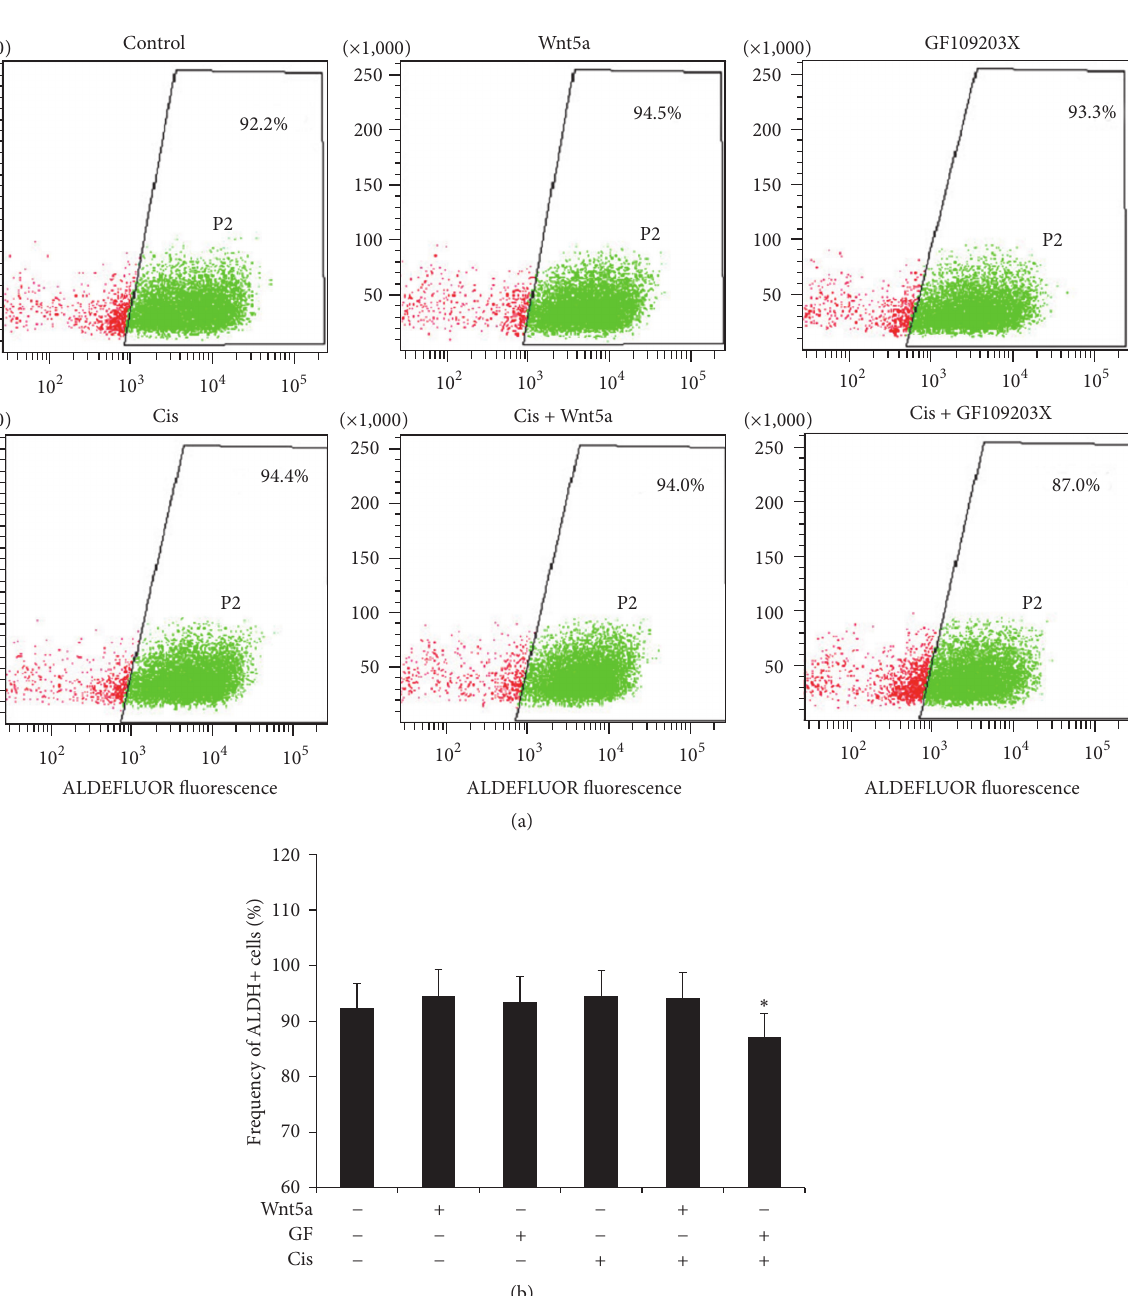
Figure 5: An inhibition of PKC signaling reduces the fraction of ALDH-positive in cisplatin-resistant lung cancer cells. A549/DDP cells were cultured in medium containing Wnt5a, PKC inhibitor GF109203X, and/or cisplatin for 24 hours; the cells were then harvested for ALDH staining and flow cytometric analysis. (a) Representative cytometric plots showed the positive fractions of ALDH-positive cells treated with indicated conditions. (b) A quantitative analysis of flow cytometry data showed Wnt5a slightly increased ALDH-positive cell fraction in A549/DDP cells in the absence of cisplatin, and an inhibition of PKC signaling by GF109203 significantly reduced the frequency of ALDH- cells in the presence of cisplatin. Compared to the corresponding non-GF109203X-treated group and other groups, ∗ represents 𝑝 < 0.05 . All data are represented as the mean ± SD of three independent triplicated experiments ( 𝑁 = 9 ). GF: